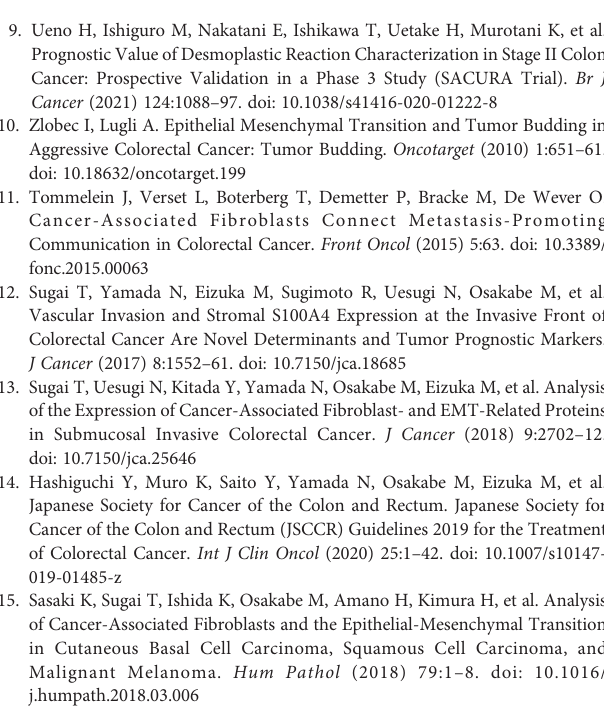
Supplementary Figure 1 | Histological features of the invasive front. (A) Low- power view of the invasive area of CRC. (B) High-power view of the invasive area of CRC (mature type desmoplastic reaction). (C) Low-power view of the invasive area of CRC. (D) High-power view of the invasive area of CRC (intermediate type desmoplastic reaction). (E) Low-power view of the invasive area of CRC. (F) High- power view of the invasive area of CRC (immature type desmoplastic reaction). Supplementary Figure 2 | Kaplan-Meier analyses of the disease-free survival (A) and overall survival (B) based on each subgroup of the fi rst